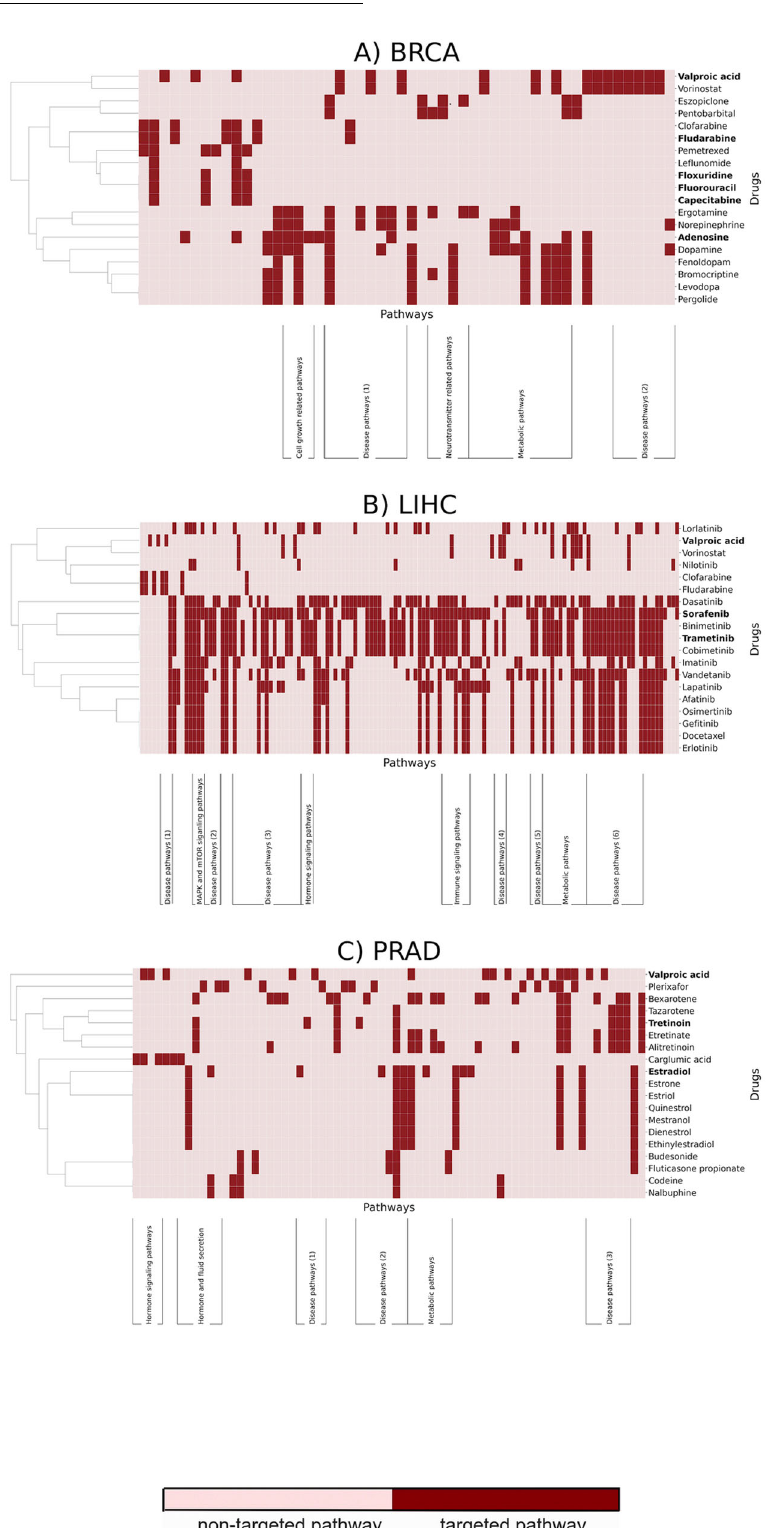
Fig. 2 Pathways targeted by prioritized drugs in DrugCentral for each of the three cancer test datasets. The X axis corresponds to pathways targeted by any of the prioritized drugs (i.e., pathways not targeted by any prioritized drug are omitted for better visualization). Prioritized drugs for each cancer dataset have been clustered based on the pathways they target and are reported on the Y axis. Of the prioritized drugs, those that correspond to true positives are highlighted in bold. If a set of three or more similar pathways was clustered together, we manually assigned these pathways into distinct classes (Y axis) Pathway names and cluster information are available as a Supplementary File and the equivalent fi gures for DrugBank are available as Supplementary Figs. 2 –